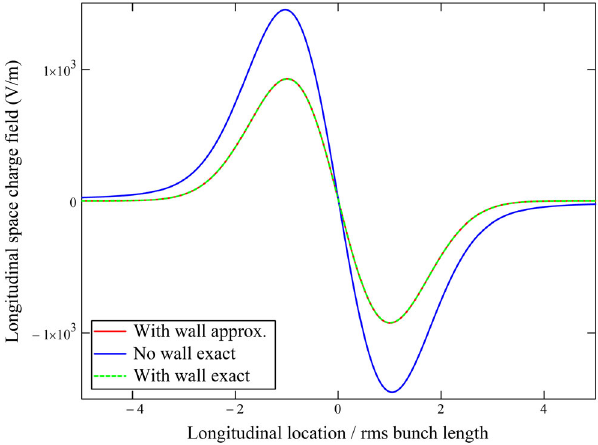
FIG. 10. The longitudinal space charge field of an electron bunch in the free space (blue) and, inside a beam pipe (red and green) with inner radius of 2.54 cm. The blue curve is generated using Eq. (19) for an electron bunch in the free space, the red curve is produced by the approximate formula, Eq. (33), for a long electron bunch inside a beam pipe, and the green curve is created from the exact formula, Eq. (34), for an electron bunch with arbitrary length inside a beam pipe. The parameters of the proof of CeC principle experiment are applied for all plots.